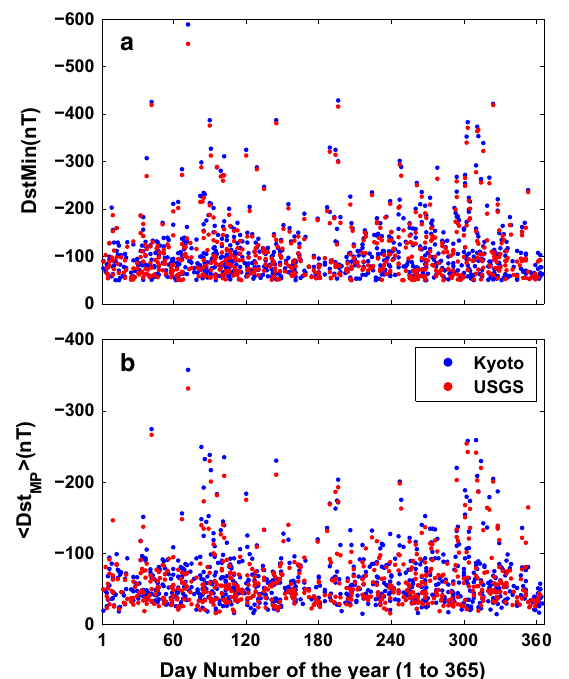
Fig. 5 Scatter plots of DstMin ( a ) and ⟨ Dst MP ⟩ ( b ) of each storm as a function of day of the year with blue dots for Kyoto Dst and red dots for USGS Dst. The scatter is large due to the storms being moderate to super and in 50 years